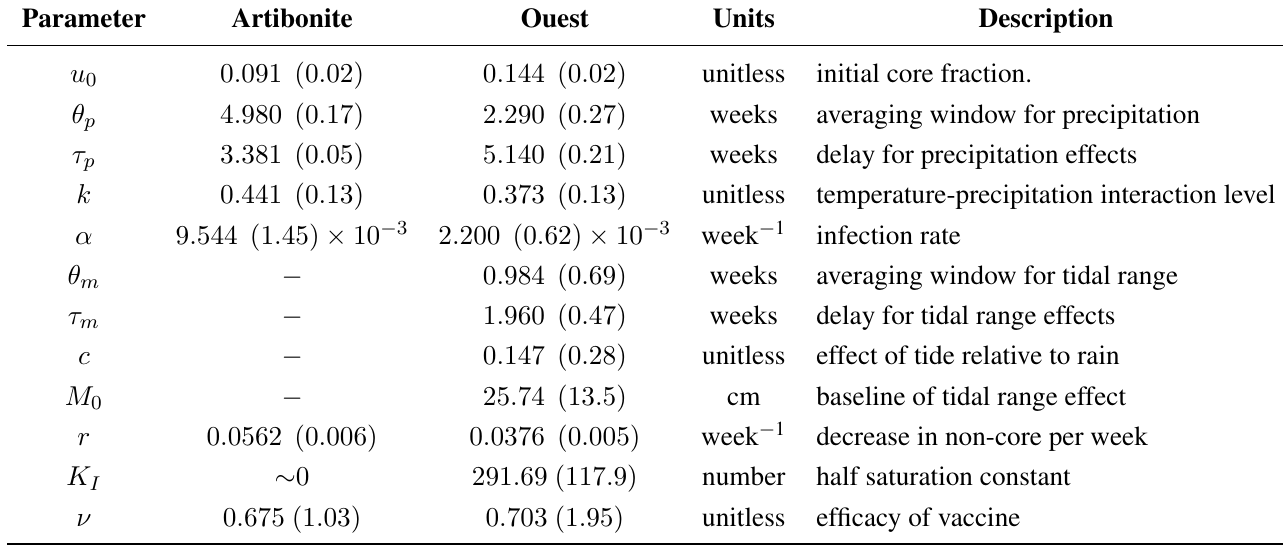
Table 2. . Numbers in parentheses are the 95 % confidence intervals